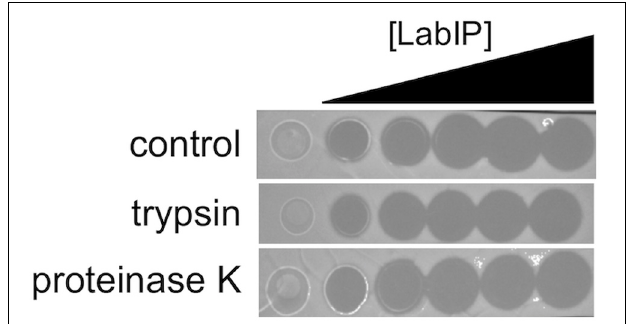
FIGURE 8 | Sequestration of bacteriocins within MVs. The stable maintenance of bacteriocin peptide within MVs was determined by weeklong incubation followed by separation by MWCO filtration. Fractions were tested for bacteriocin activity using spot-on-lawn assays. Images are representative of triplicate